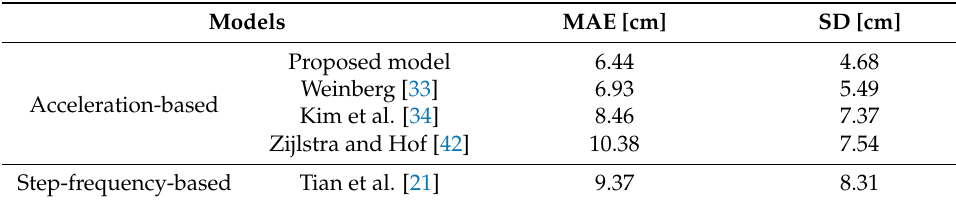
Table 2. MAEs and SDs for overall stride length